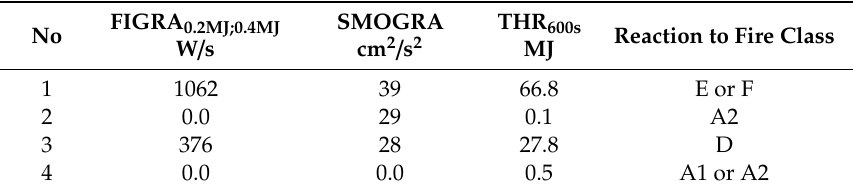
Table 5. Summary of the experimental results obtained by the means of SBI test method [25,26]; specimens are described in Section